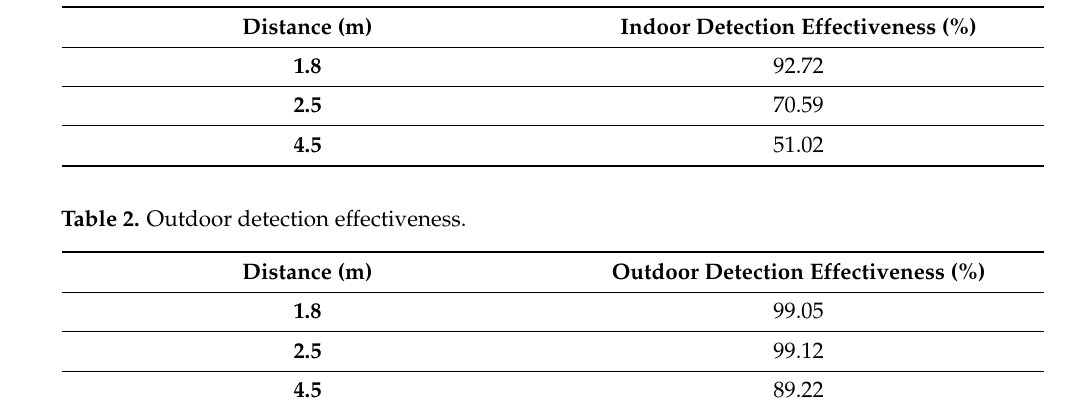
Table 1. Indoor detection effectiveness.